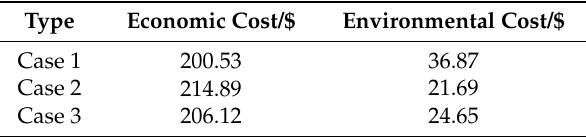
Table 6. Costs of three dispatching results.